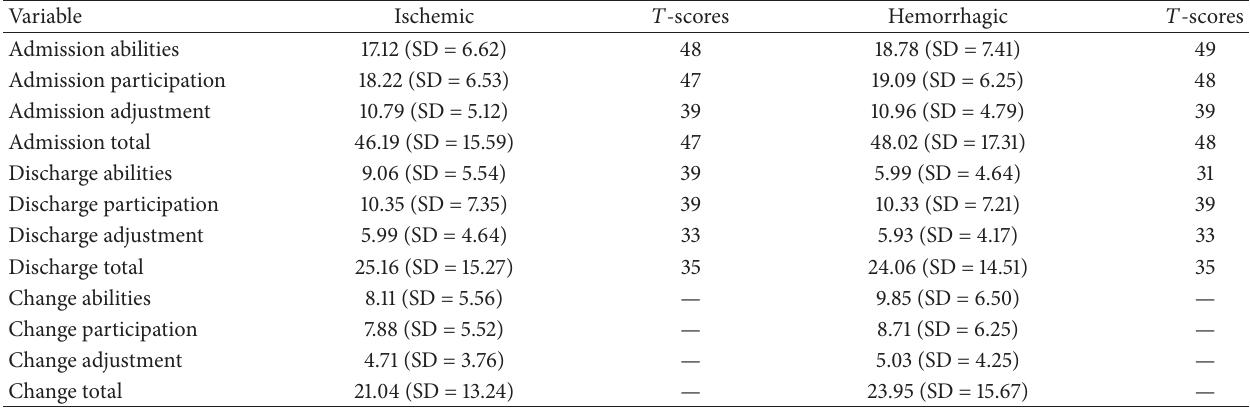
Table 2: Clinical characteristics of